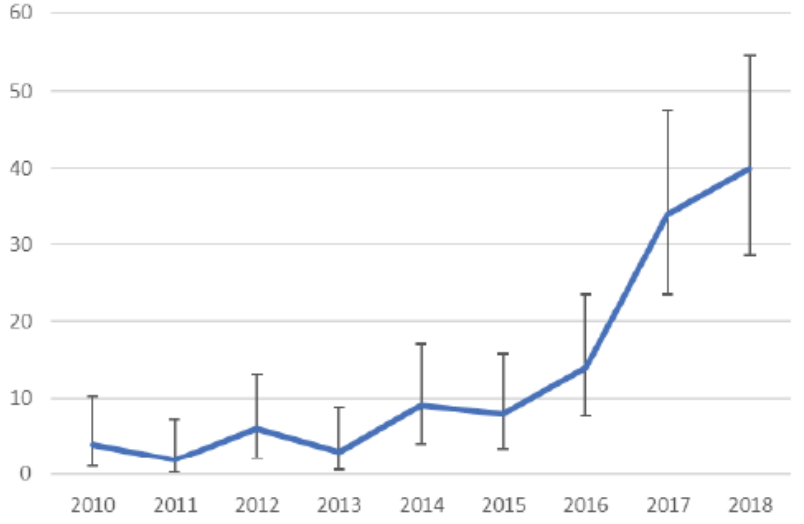
Figure 2. Comparison of individual years in terms of frequency of AED interventions. Analysis of the number of interventions by season showed no significant differences between seasons ( p = 0.332). So, it turned out that the frequency of interventions did not differentiate between seasons. The results are shown in Table